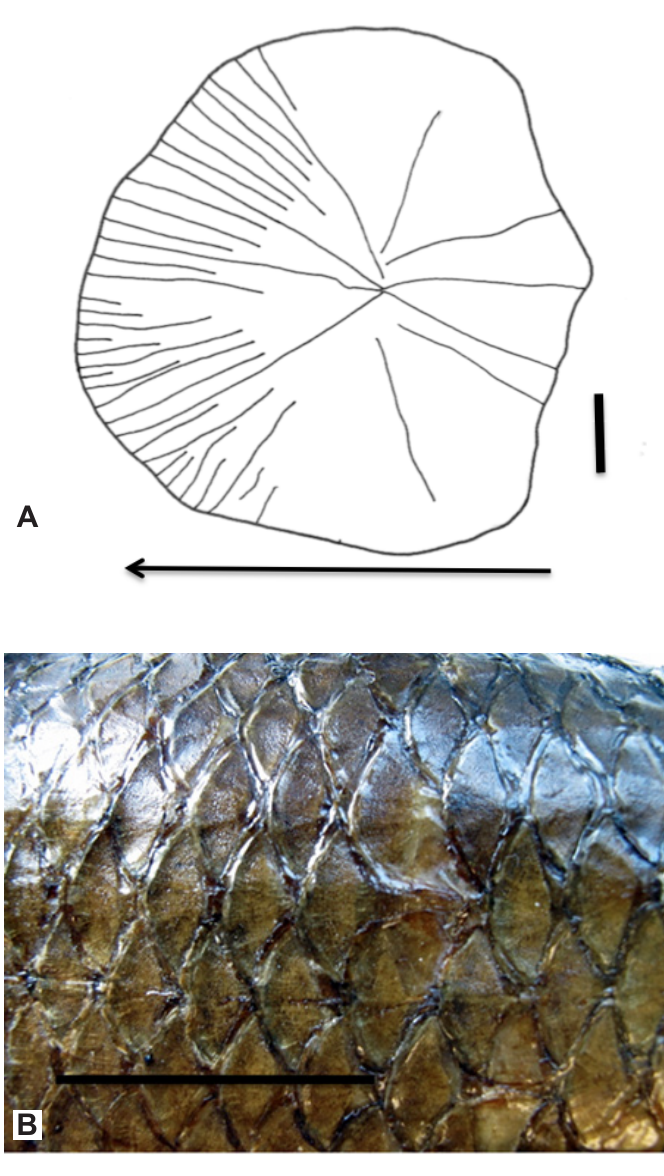
Fig. 2. A . A scale of the witvis Cheilobarbus capensis Smith, 1841 (SAIAB 52691) drawn by camera lucida to show the pattern of striae. Scale bar = 1 mm. Arrow indicates anterior (embedded field) to posterior (exposed field) orientation. Primary radii reach from radial centre to scale edge; secondary radii do not reach radial centre. B . Close up of the scales from the right flank of the lectotype of Barbus capensis (NHMUK 1845.7.3.99). Scale bar = 5 cm. Photograph by E.